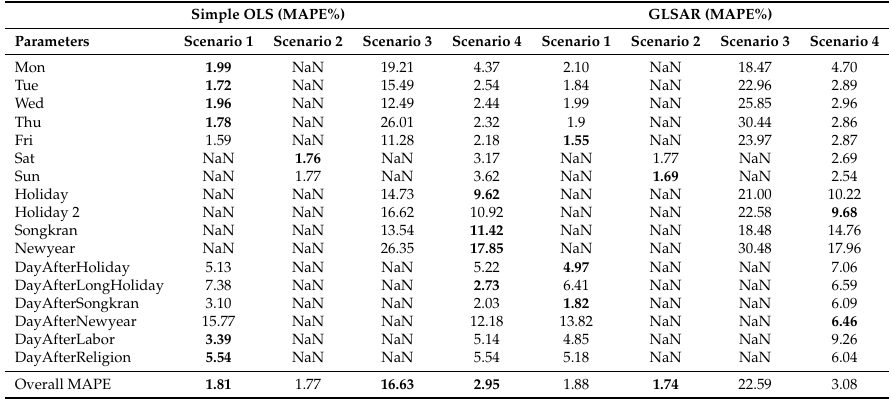
Table 7. Forecasting accuracy (MAPE%) comparison: all